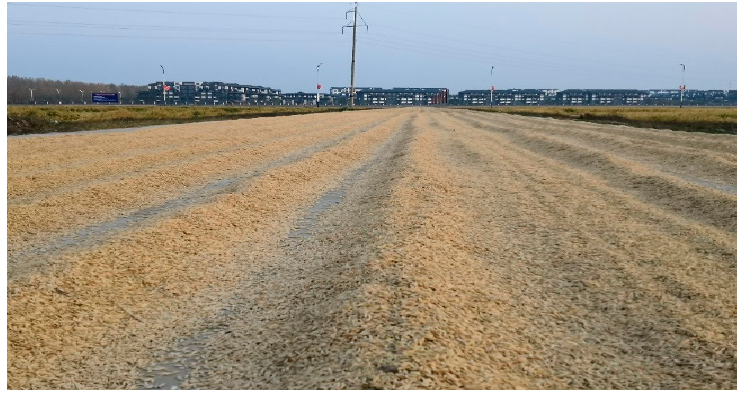
Figure 9. Road drying in Jilin city.